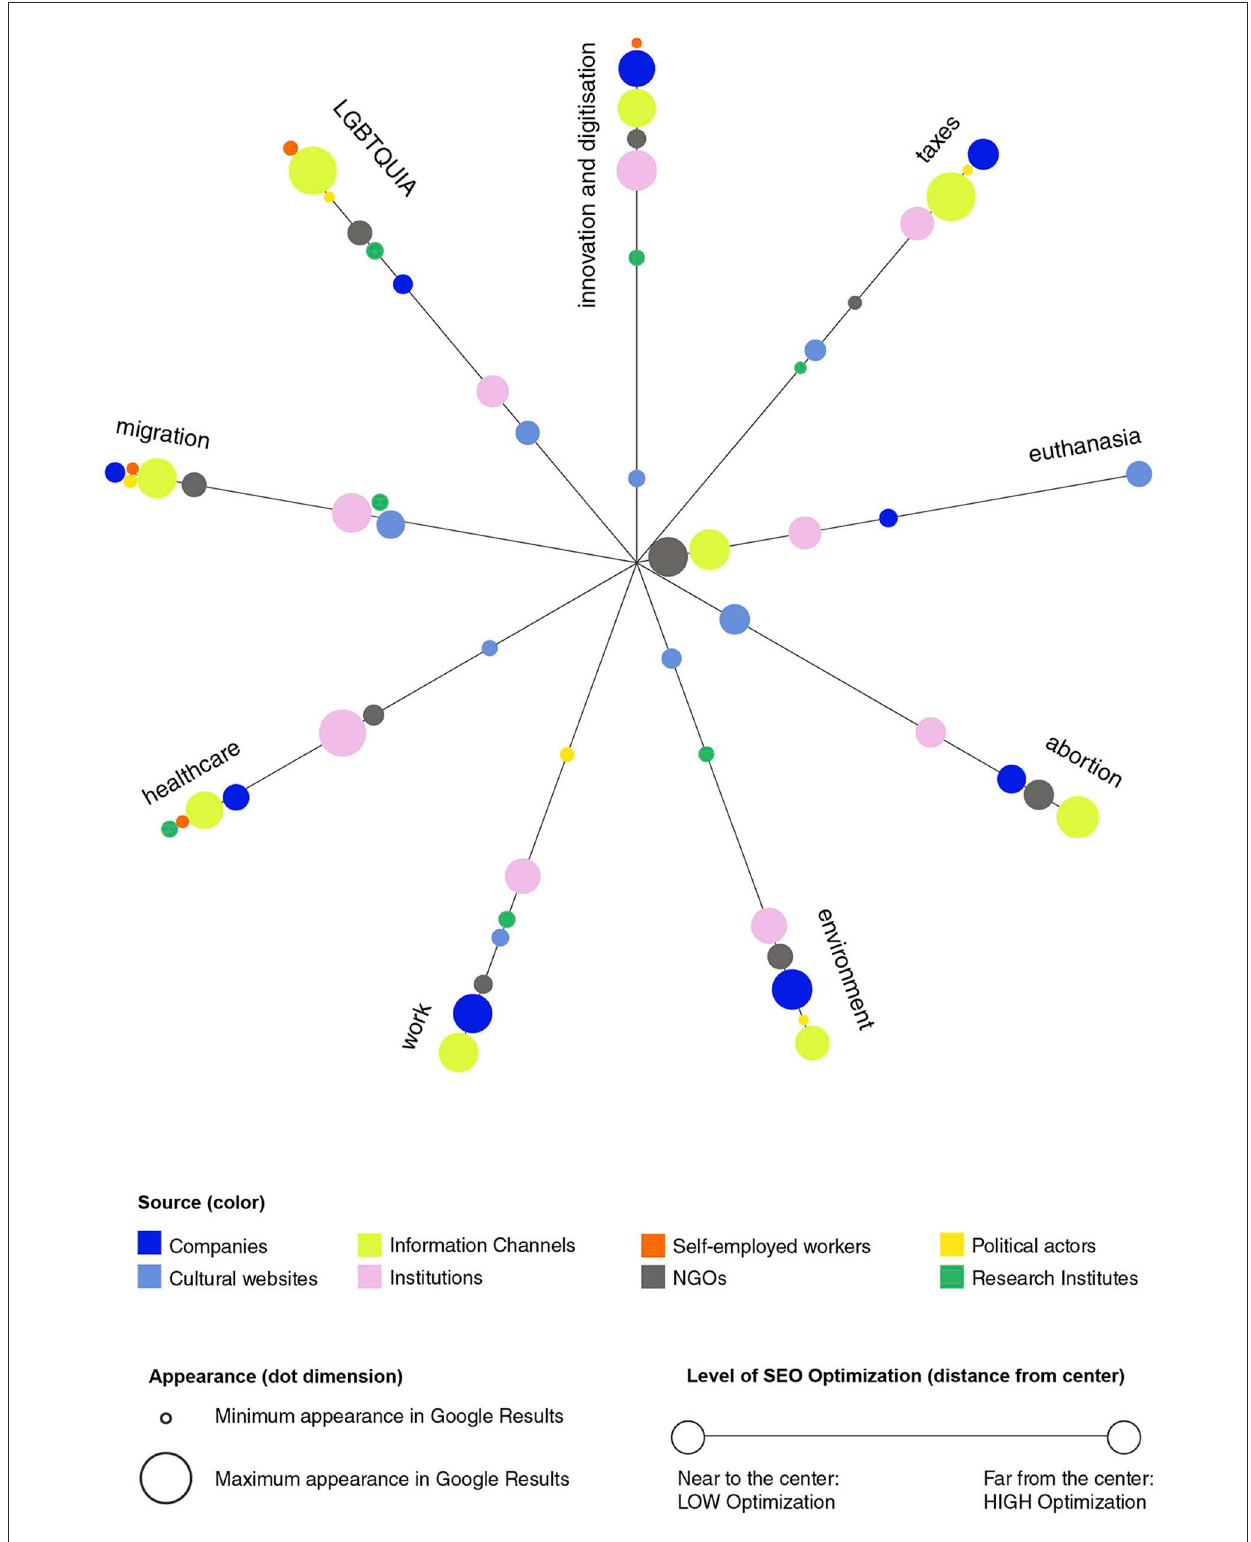
FIGURE1 Optimization percentage per topic. Dot colors correspond to different actors (refer to legend), and their size corresponds to the frequency of occurrence in the dataset.